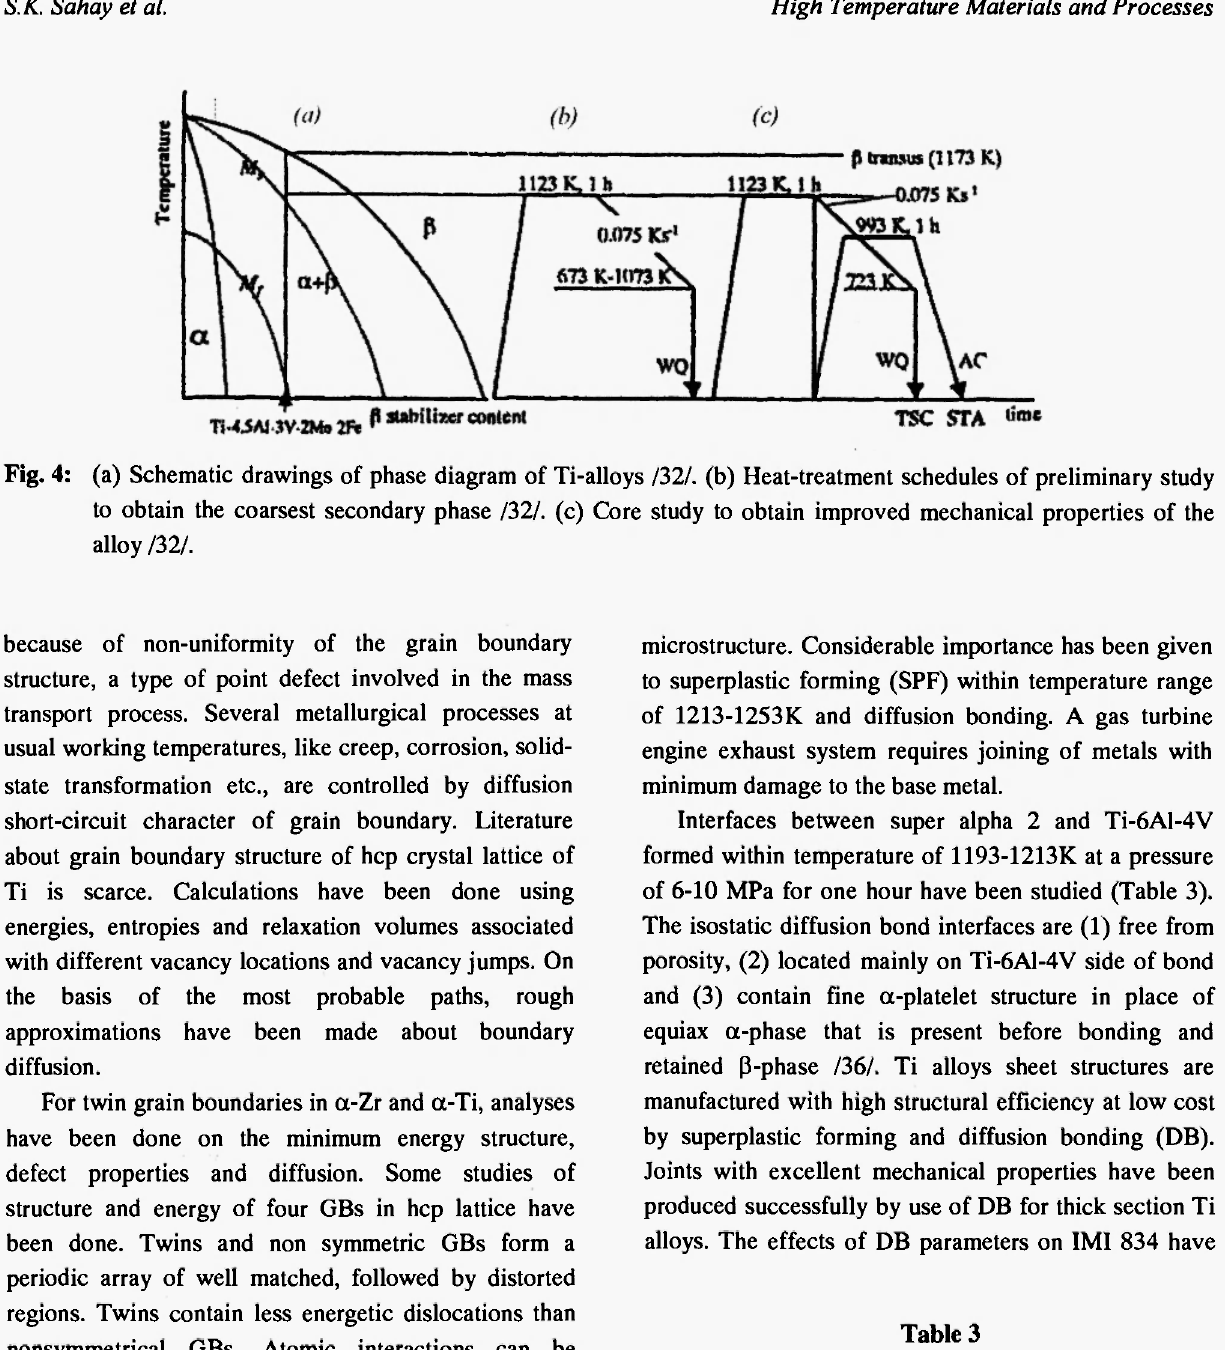
Shear strength of super alpha-2/Ti-6Al-4V bonds for given bonding conditions